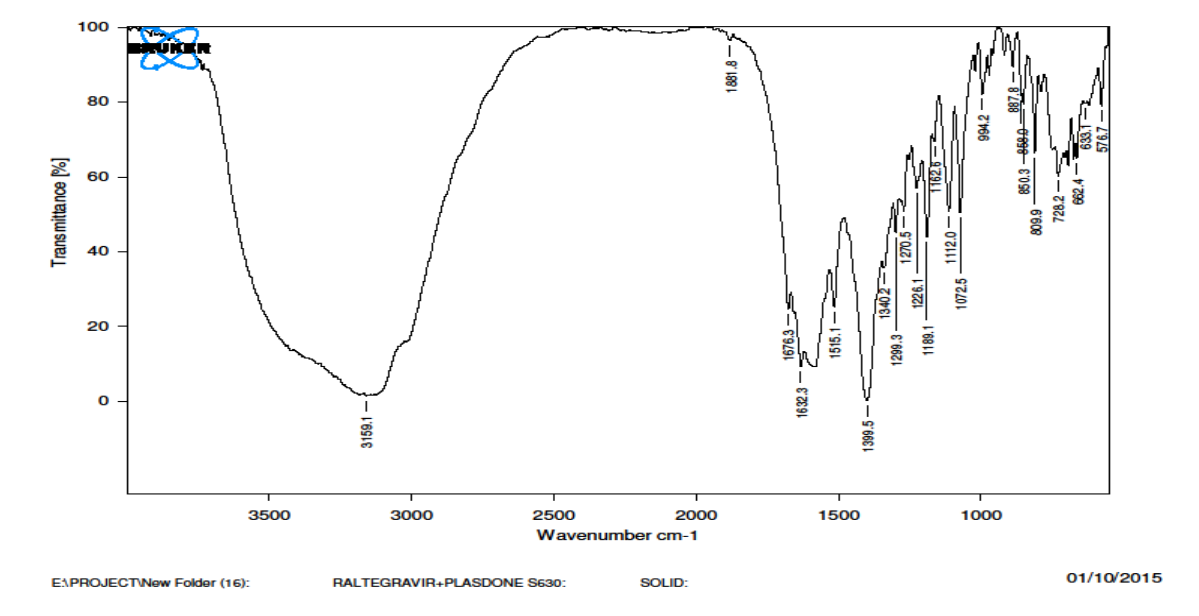
Figure 6. FTIR spectra of raltegravir HME best formulation (Trial 6)